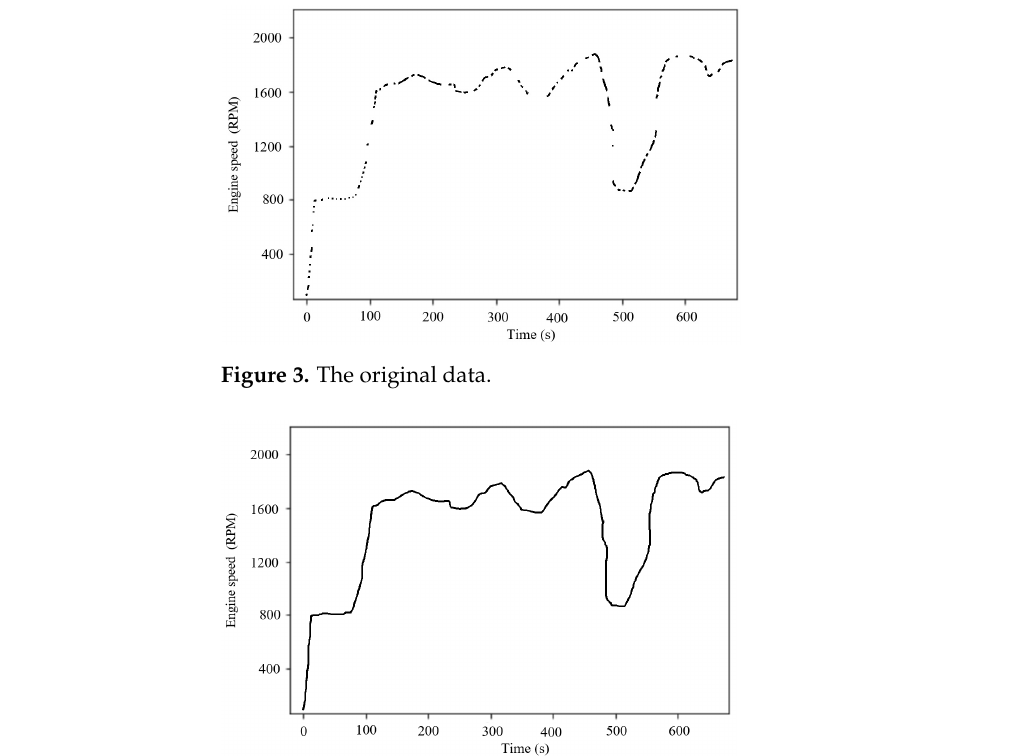
Figure 4. The processed data.